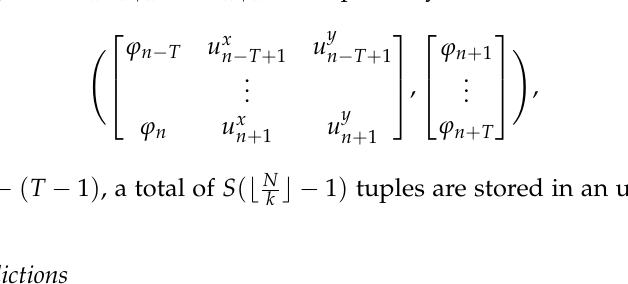
n + 10 ( bottom row